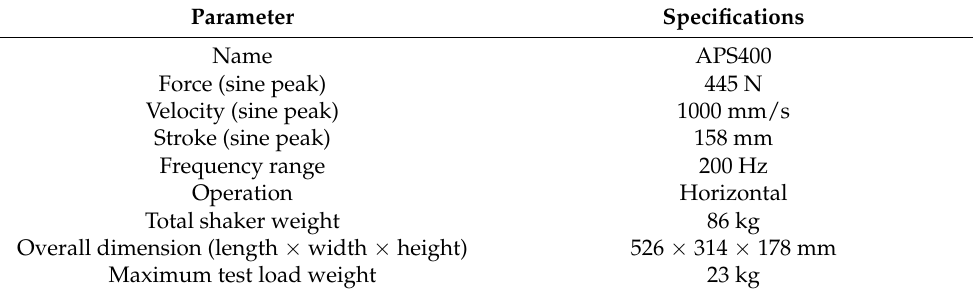
Figure 4. Uniaxial small-scale shaking table. Table 2. Specifications of a small-scale shaking table.